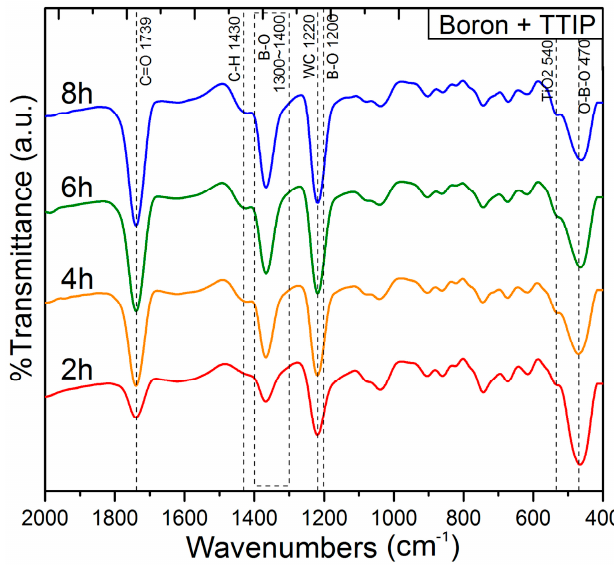
Figure 9. Variation in the Fourier transform infrared (FT-IR) spectra of the samples in the presence of TTIP with increasing milling operation time.